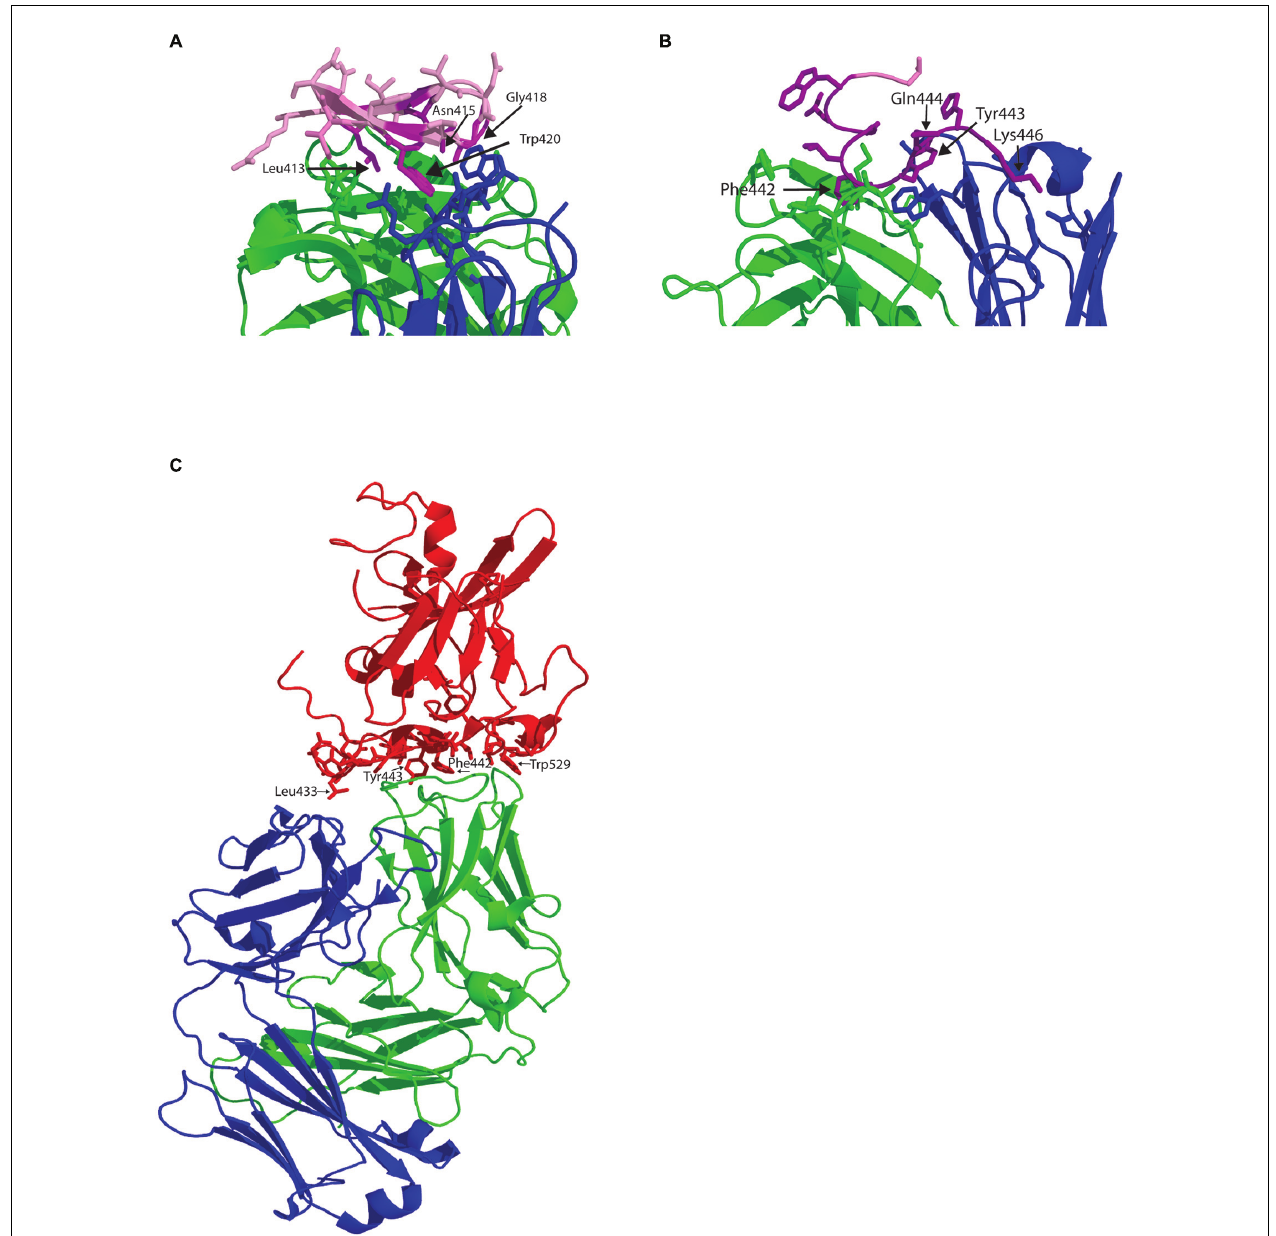
within the peptide shown as purple sticks. (B) Structure of the paratope of HC84-1 with its epitope spanning 435–446. Labeled as for A . (C) Structure of the E2 core domain in complex with neutralizing antibody AR3C. E2 is colored in red with the side chains of the amino acid in contact with the antibody shown as sticks. Heavy chain is green and light chain is